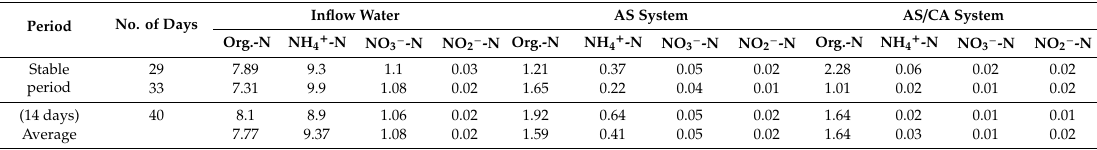
Table 8. True color of synthetic domestic sewage treated using AS system and AS/CA system . Table 9. Nitration of synthetic domestic sewage treated using AS system and AS / CA system in stable Stage.